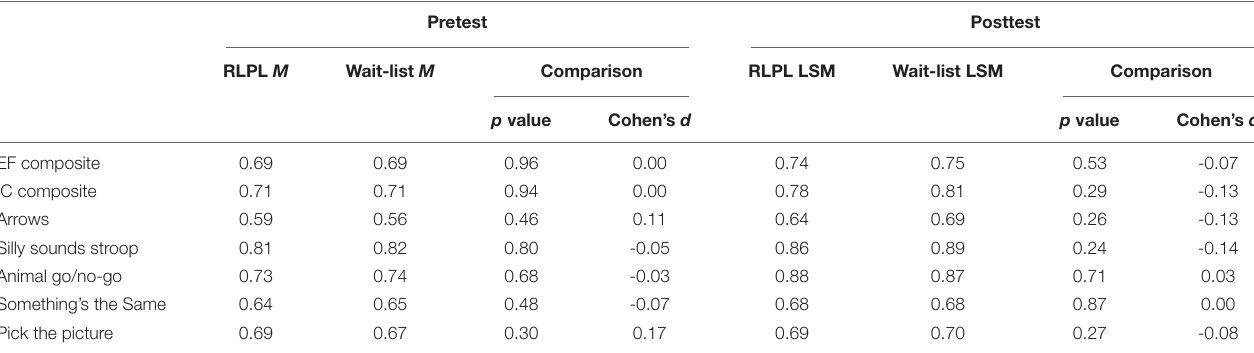
TABLE 5 | Comparison of treatment conditions at pretest and